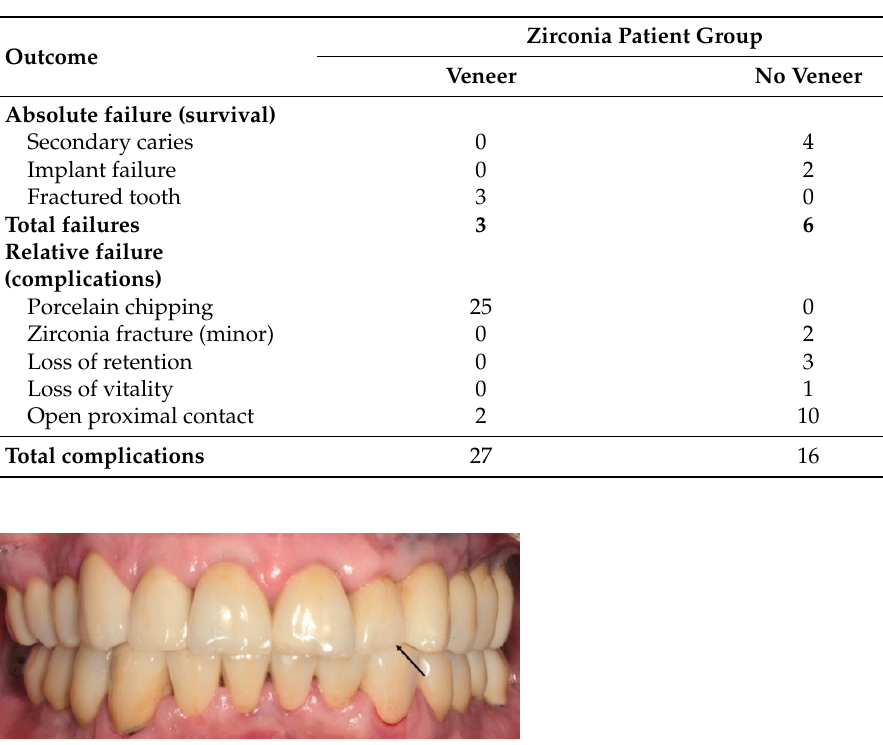
Figure 5. The arrow shows an open contact point between implant restoration and adjacent tooth that needs to be repaired because of impacted food . Therefore, the implant restoration was removed, and feldspathic porcelain was added in order to achieve better contact with the adjacent tooth. 3.4. California Dental Association Ratings The non-veneered and veneered monolithic zirconia restorations received separate CDA ratings. In the non-veneered monolithic zirconia restorations, the surfaces were excellent (100%) and the color was satisfactory (100%). The shape was excellent in 80% of the restora- tions, 0.9% were unsatisfactory-irreparable (two restorations were replaced due to implant failures) and 19.1% were satisfactory, including the 10 open contacts between implants and teeth without food impaction. The margins were excellent in 56% of the restorations; 1.7% were unsatisfactory and irreparable due to four secondary caries that needed to be replaced. The rest were rated as satisfactory with slight over-contouring (42.3%). Overall, 2.6% needed to be replaced, and the remaining 97.4% non-veneered monolithic zirconia restorations were evaluated as satisfactory and not in need of any repair or revision (Figure 6).